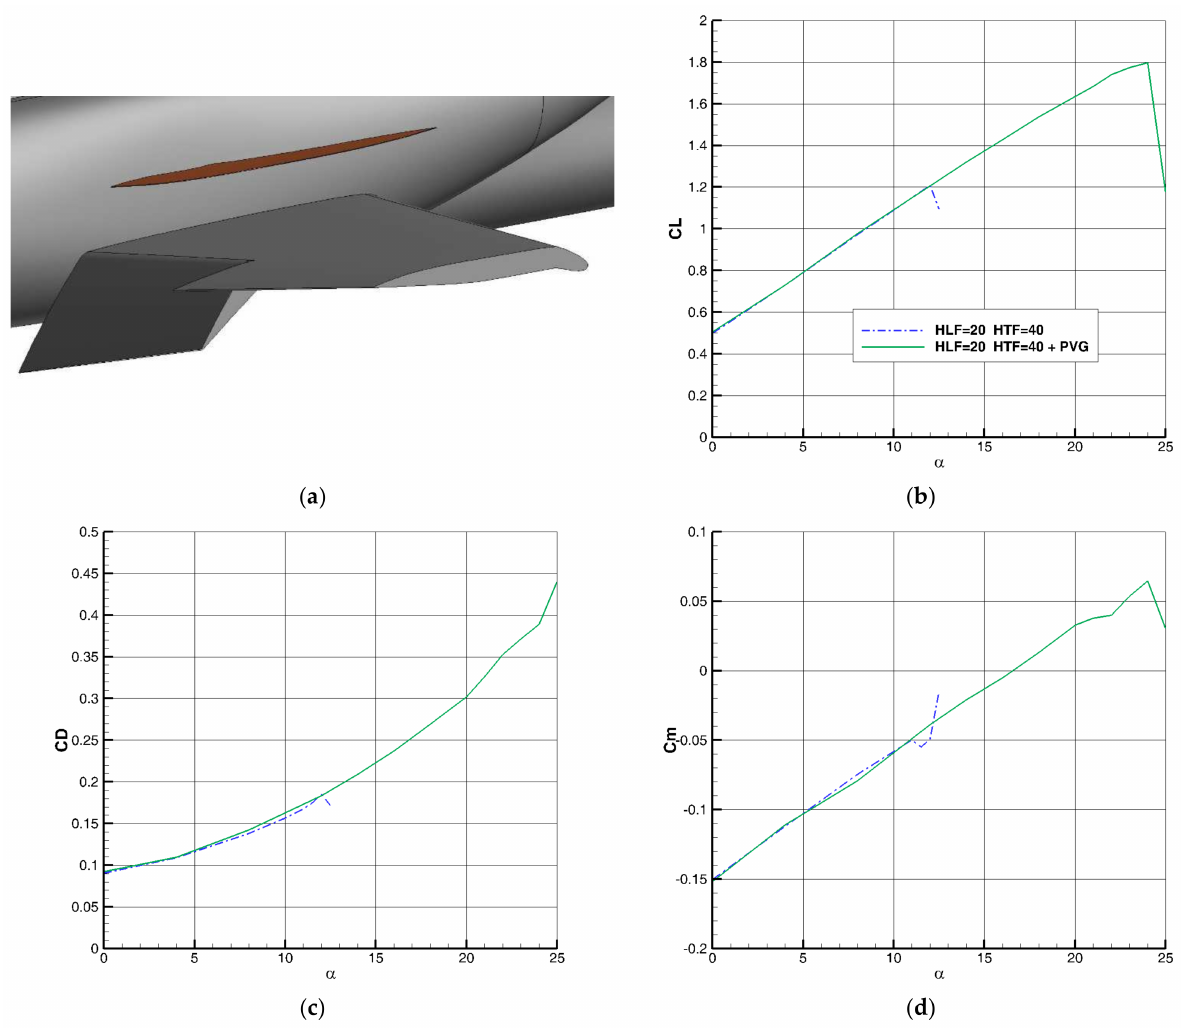
Figure 16. Effect of PVG on the HLF and HTF configurations of the wing-body in V = 60 m/s: ( a ) the HLF and HTF configurations; ( b ) C L − α diagram; ( c ) C D − α diagram; ( d ) C m − α